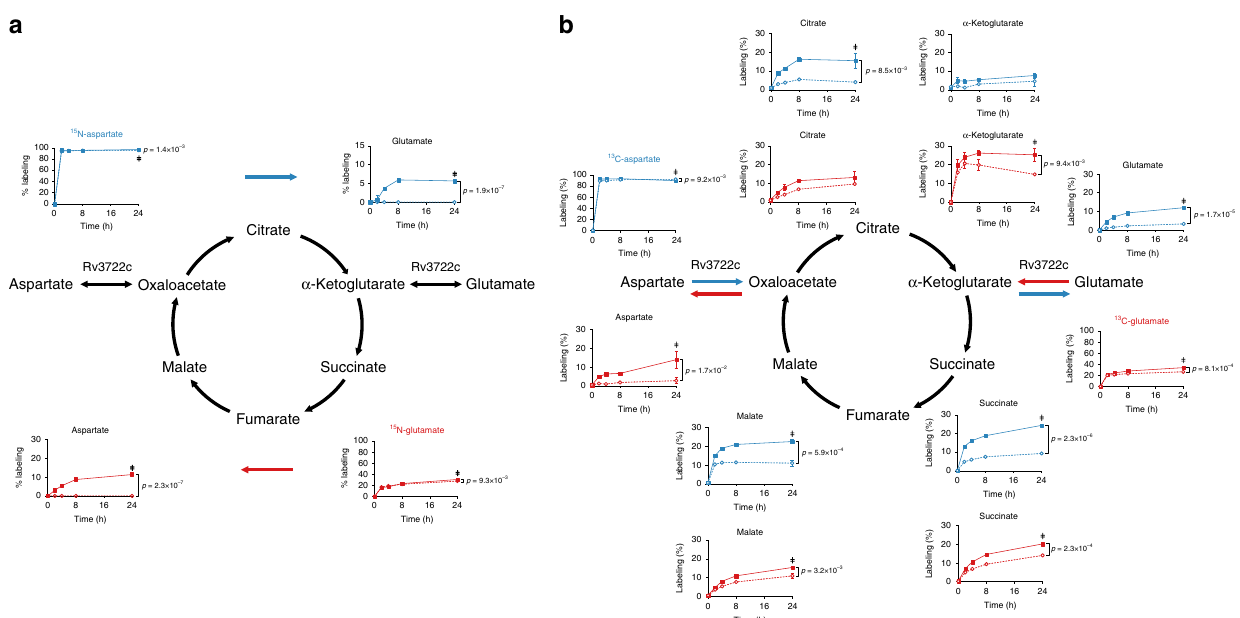
Fig. 5 Rv3722c is the main aspartate aminotransferase in Mtb. a 15 N-stable isotope tracing in Rv3722c-pro fi cient and -de fi cient Mtb . Rv3722c-TetON was cultured in 7H9 supplemented with casein hydrolysate, with or without ATC, to predeplete Rv3722c. After a 3 h adaptation to unsupplemented 7H9 with (solid line) or without ATC (dashed line), 15 N-Asp (blue) or 15 N-Glu (red) was added to the media at a fi nal concentration of 3 mM. After 0, 2, 4, 8, and 24 h at 37 °C, 15 N labeling of the indicated metabolites was determined using LC-MS. Colored arrows indicate the direction of the Rv3722c-mediated reaction. b 13 C-stable isotope tracing in Rv3722c-pro fi cient and -de fi cient Mtb . Same as ( a ), but using 13 C 4 -Asp (blue) or 13 C 5 -Glu (red). Percentages are relative to the sum of all isotopes and corrected for natural isotope abundance. Data are presented as mean + / − SD of three experimental replicates ( n = 3, but n = 2 for all 2h-ATC timepoints in a and Asp + ATC-4h, 15 N-Glu + ATC-4h in a , due to sample loss), representative of two independent experiments. Statistically signi fi cant differences were identi fi ed by a combination of a two-sided unpaired Student's t test ( p < 0.05, as indicated) and Mann – Whitney U rank testing (for which the smallest possible p -value with n = 3 is 0.1) (double dagger); Source data are provided as a Source Data fi